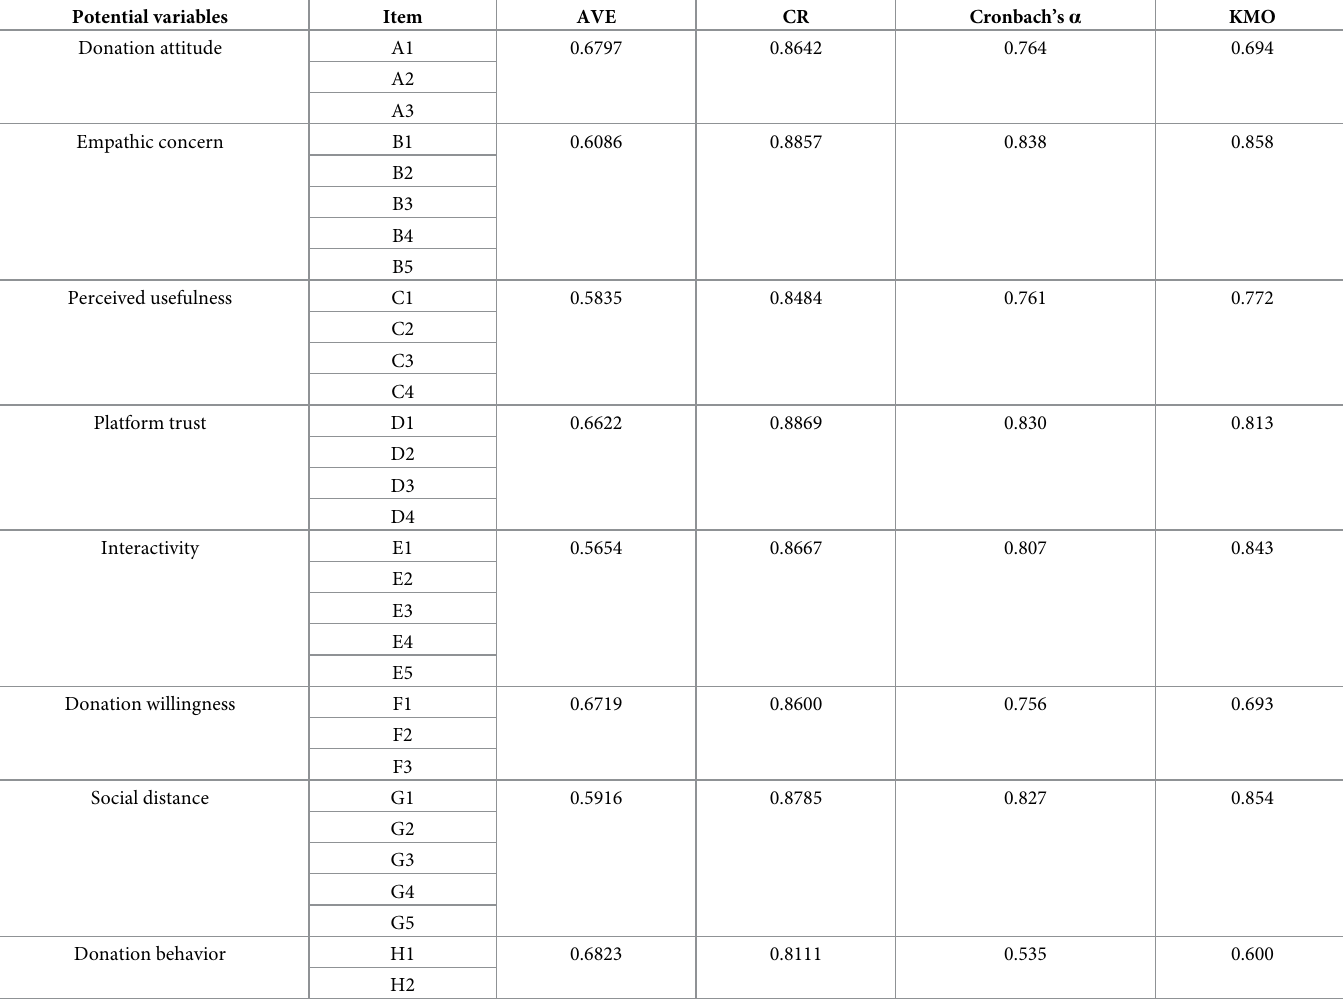
Table 2. Reliability and validity index